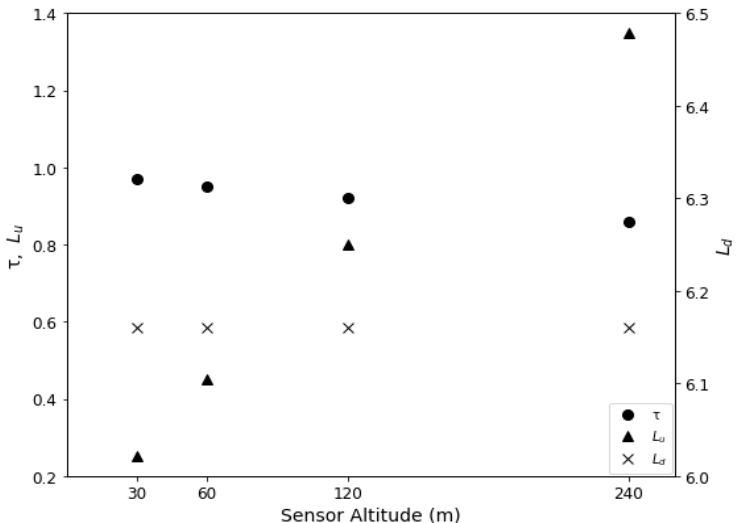
Figure 5. Modeled L u , L d and τ at the UAS scene center time on 9 August 2018 at different sensor altitudes.